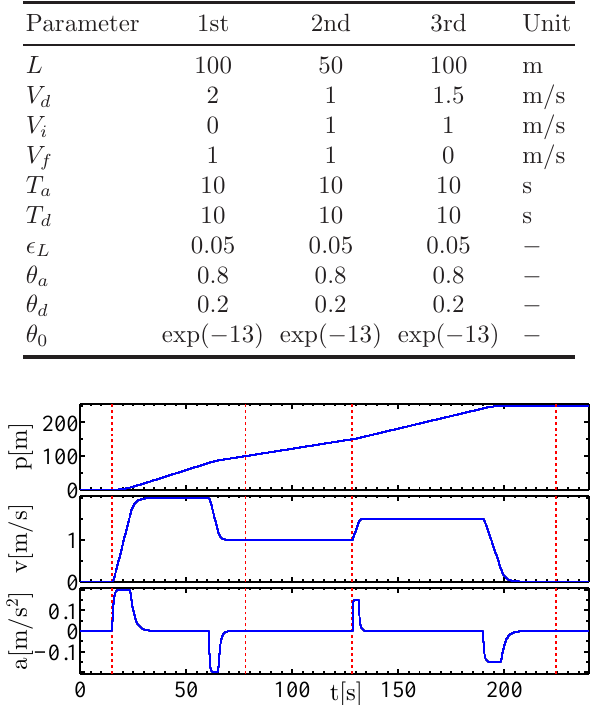
Figure 9: References synthesised by the advanced ver- sion of the RM.